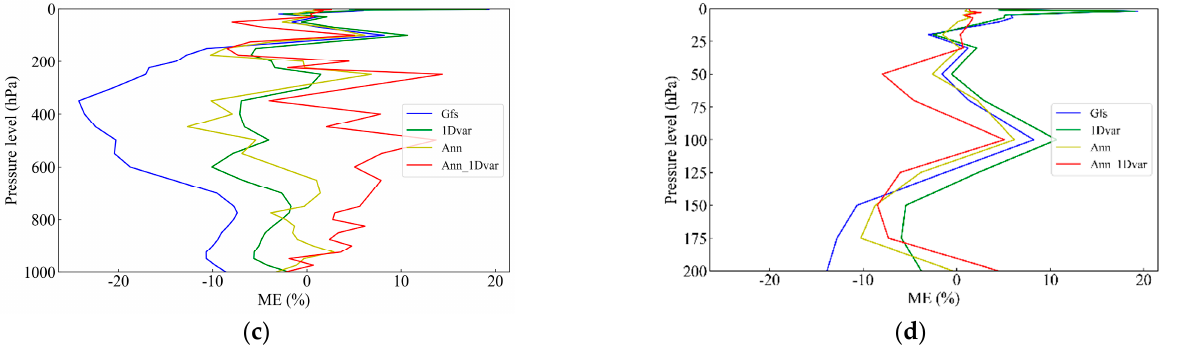
Figure 6. A comparison of the retrieval profile and initial profile, where the true value is taken from ERA5 data: ( a ) 1–1000 hPa RMSE (%) of two initial profiles and two retrieval profiles, ( b ) 1–200 hPa RMSE (%), ( c ) 1–1000 hPa ME (%), ( d ) 1–200 hPa ME (%). The blue line, GFS, is the ozone profile of GFS forecast data, and the green line, 1Dvar, is the traditional 1D − VAR physical retrieval algorithm retrieval ozone profile result obtained with GFS data as the initial profile. The yellow line, Ann, is the profile obtained by the neural network model and the initial profile synthesized by GFS data, while the red line, Ann_1Dvar, is the retrieval result obtained by adding the neural network method to optimize the initial profile combined with the traditional 1D − VAR physical retrieval algorithm.